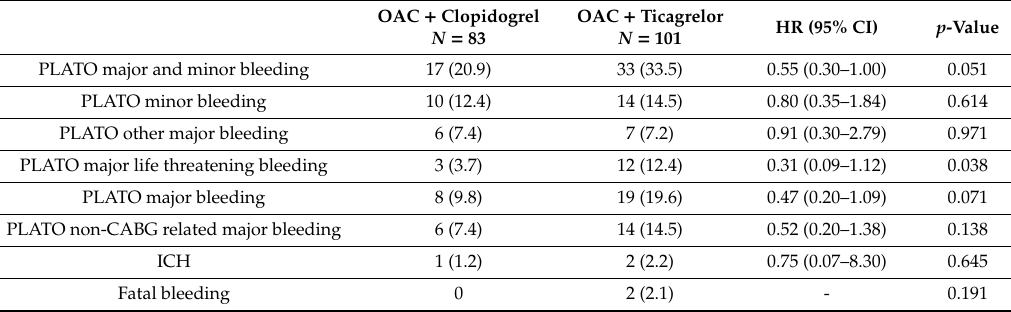
Table 3. Bleeding outcomes at 1 year.